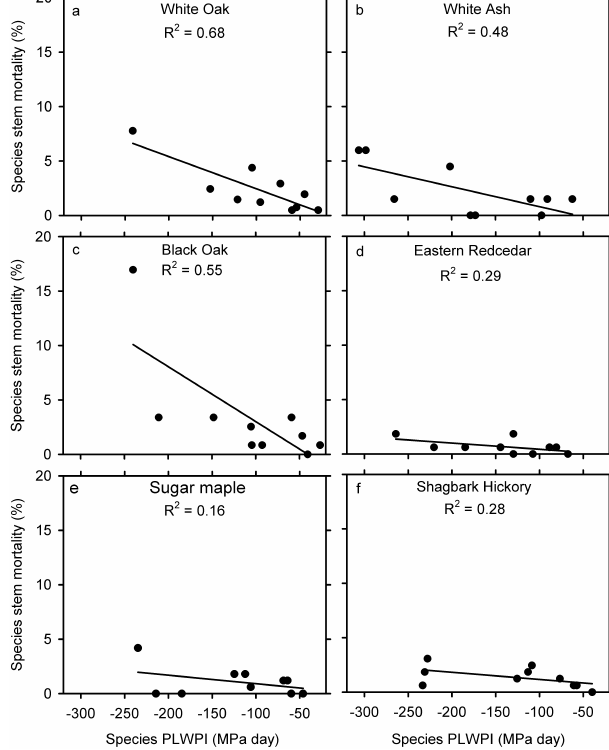
Figure 9. The species mortality expressed relative to the stem num- ber density of 2005 as a function of this species’ PLWPI in the pre- vious year. Fittings are